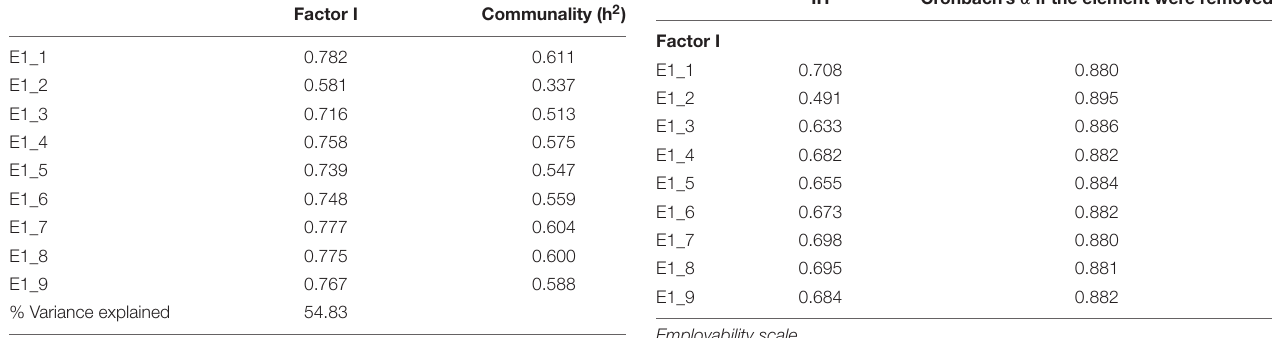
TABLE 7 | Index of homogeneity